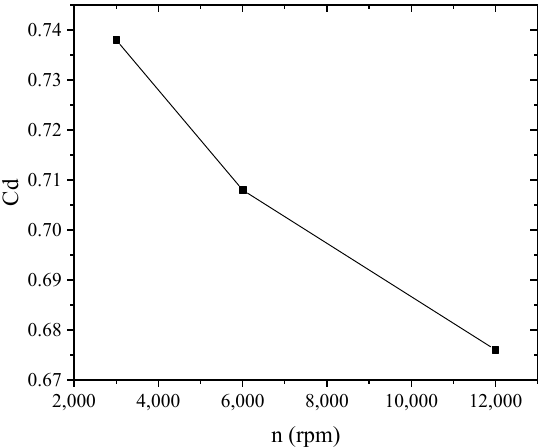
Figure 6. Relation between flow coefficient and speed.